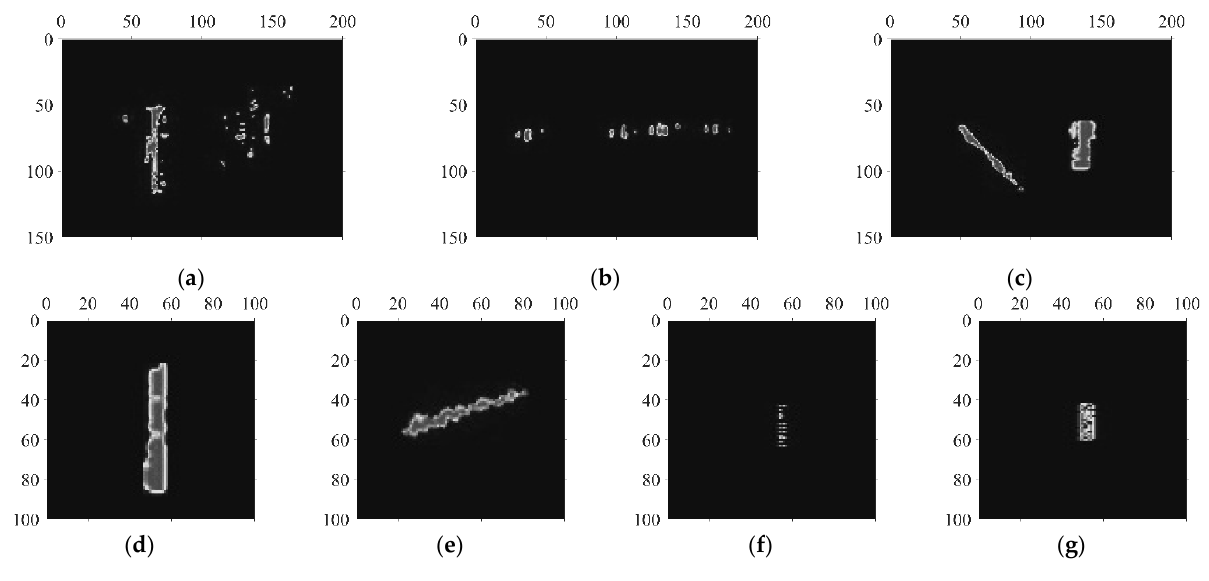
Figure 3. Grayscale images of different vibration events: ( a ) Natural wind; ( b ) HSR passing by; ( c ) Walking and climbing over fence simultaneously; ( d ) Climbing over fence; ( e ) Walking near fence; ( f ) Manual excavation; ( g ) Construction machinery.